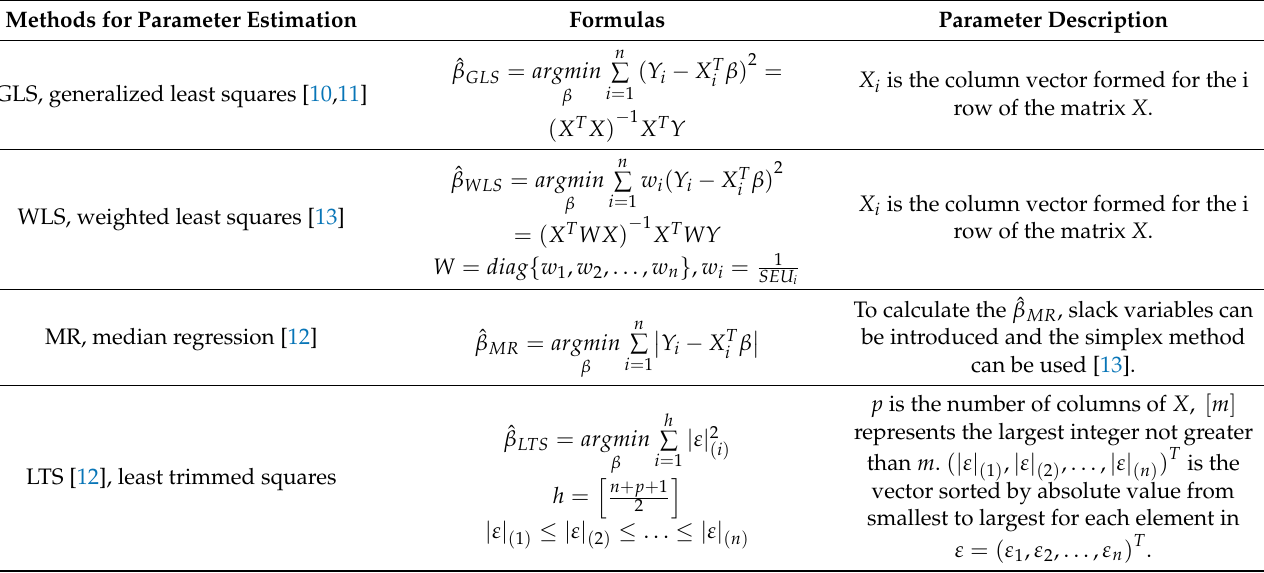
Table 4. Methods for parameter